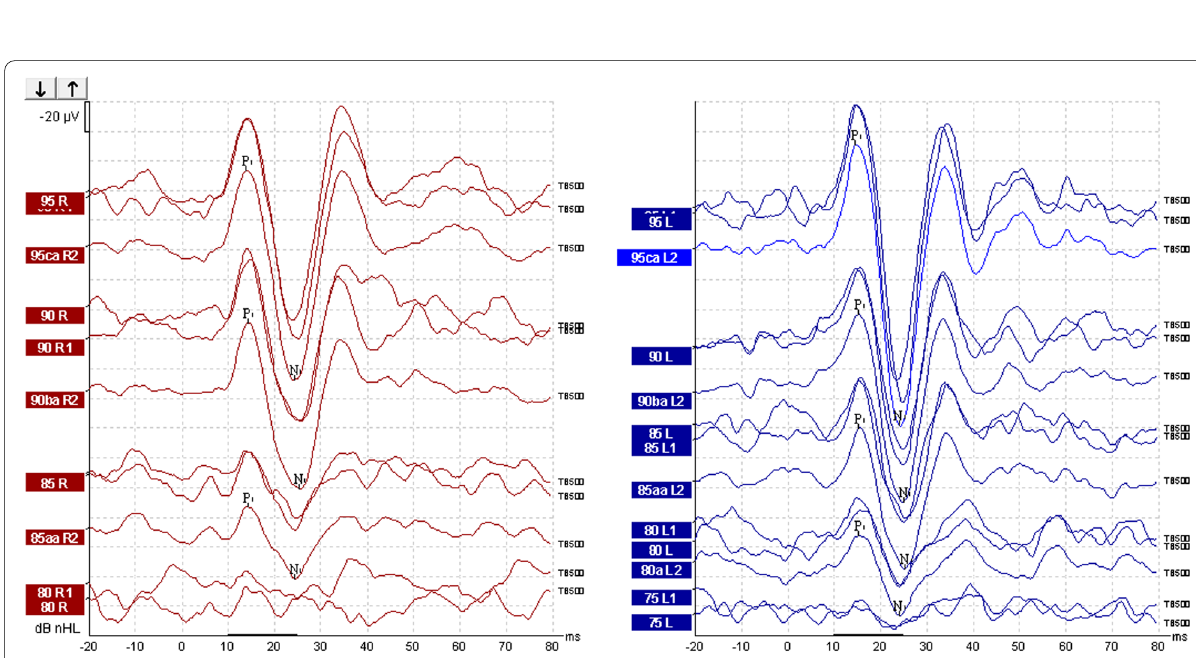
Fig. 3 Air conducted cVEMPs responses were obtained from a female individual. (AC cVEMPs responses, right ear VEMPs threshold 85 dB nHL, left ear VEMPs threshold 80 dB